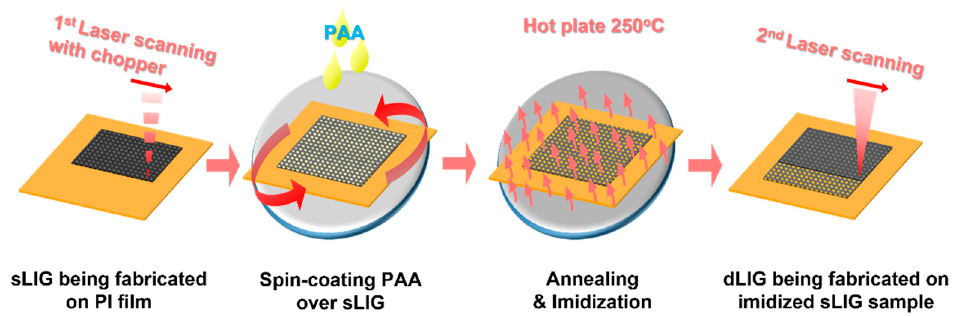
Figure 1. Fabrication process of LIG PM filters.